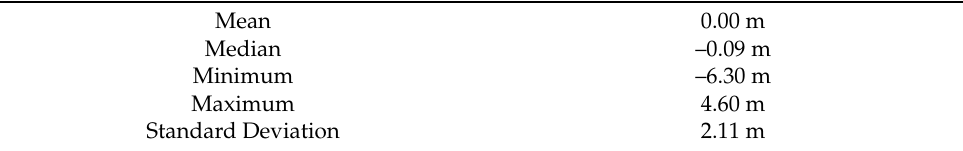
Table 4. Descriptive statistics for 2nd order bathymetric corrector surface